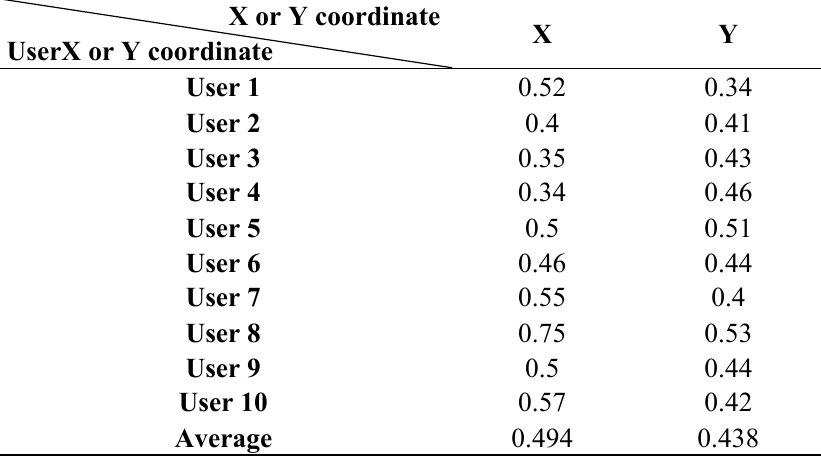
Table 8. The gaze detection errors along the X and Y-coordinate in case where the users were wearing glasses (units: °).